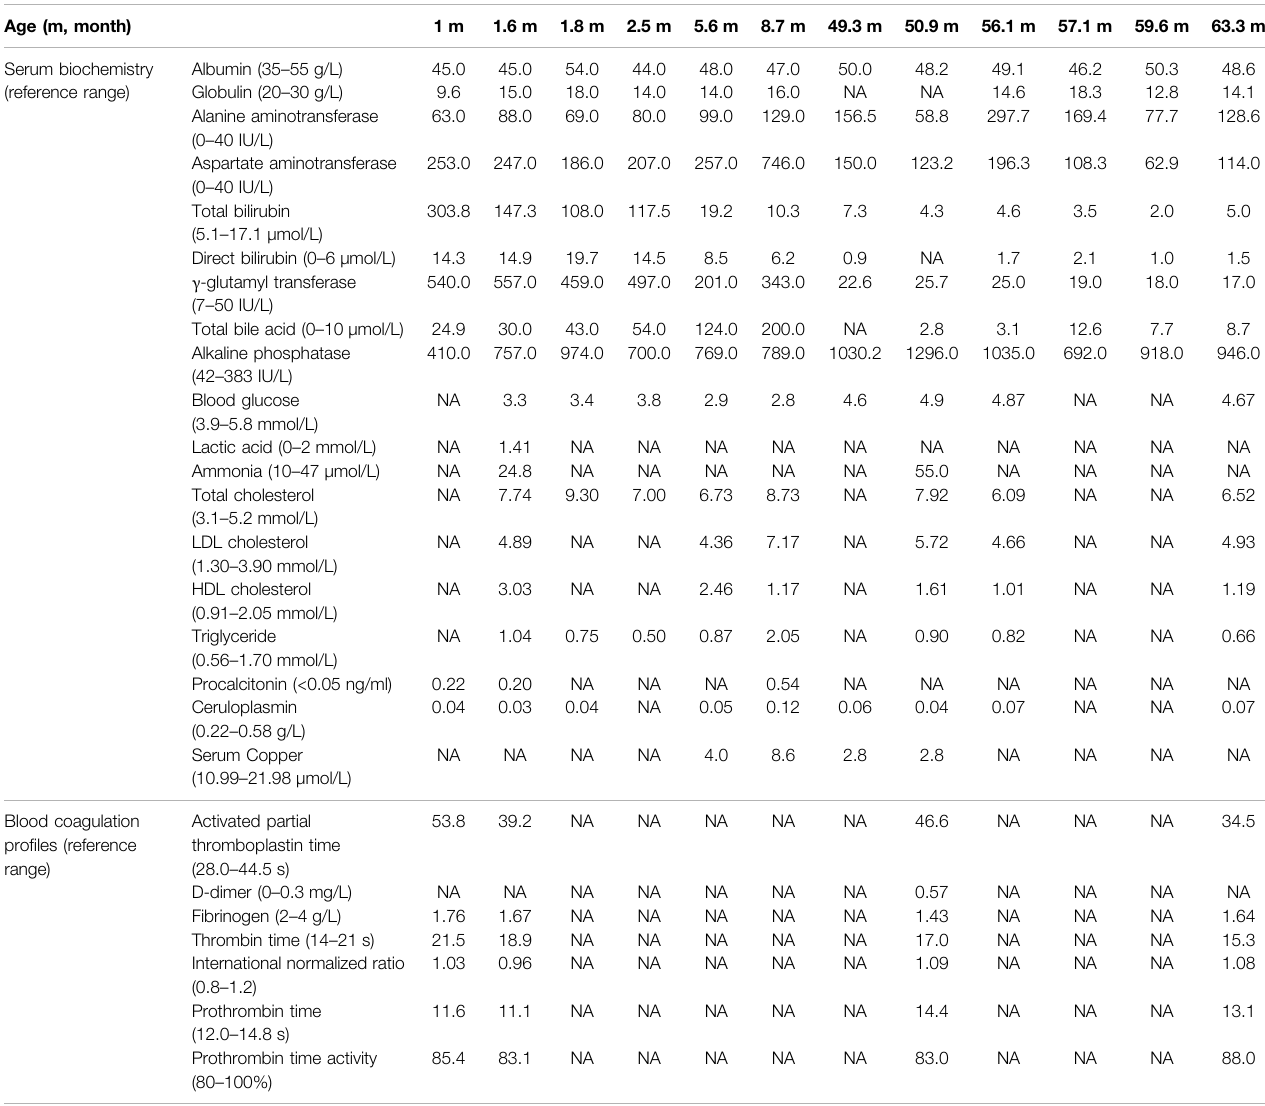
TABLE 1 | Predominant changes in laboratory investigations of the Chinese patient. Age (m, month) Serum biochemistry (reference range) (0 – 40